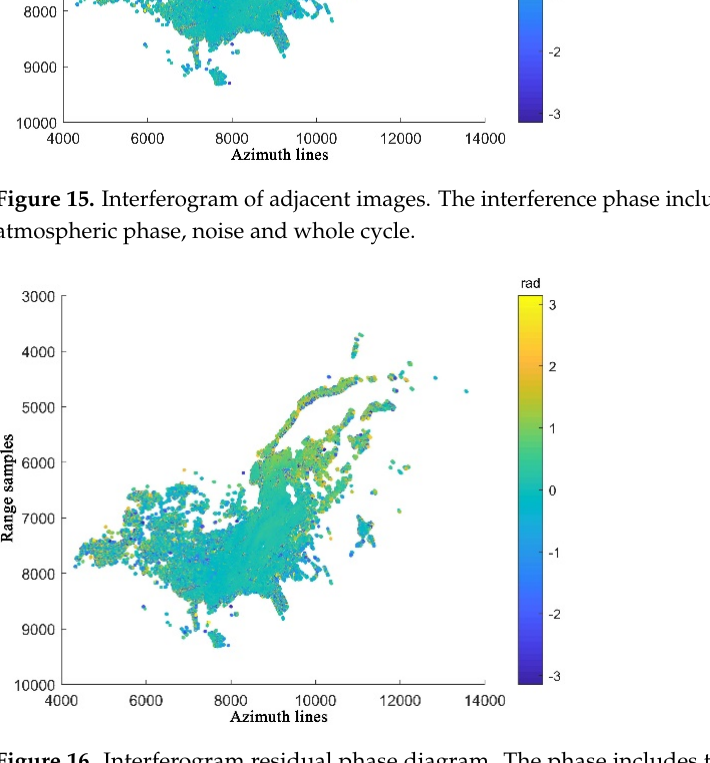
Figure 16. Interferogram residual phase diagram. The phase includes the remaining deformation phase, the remaining atmospheric phase and the whole cycle.